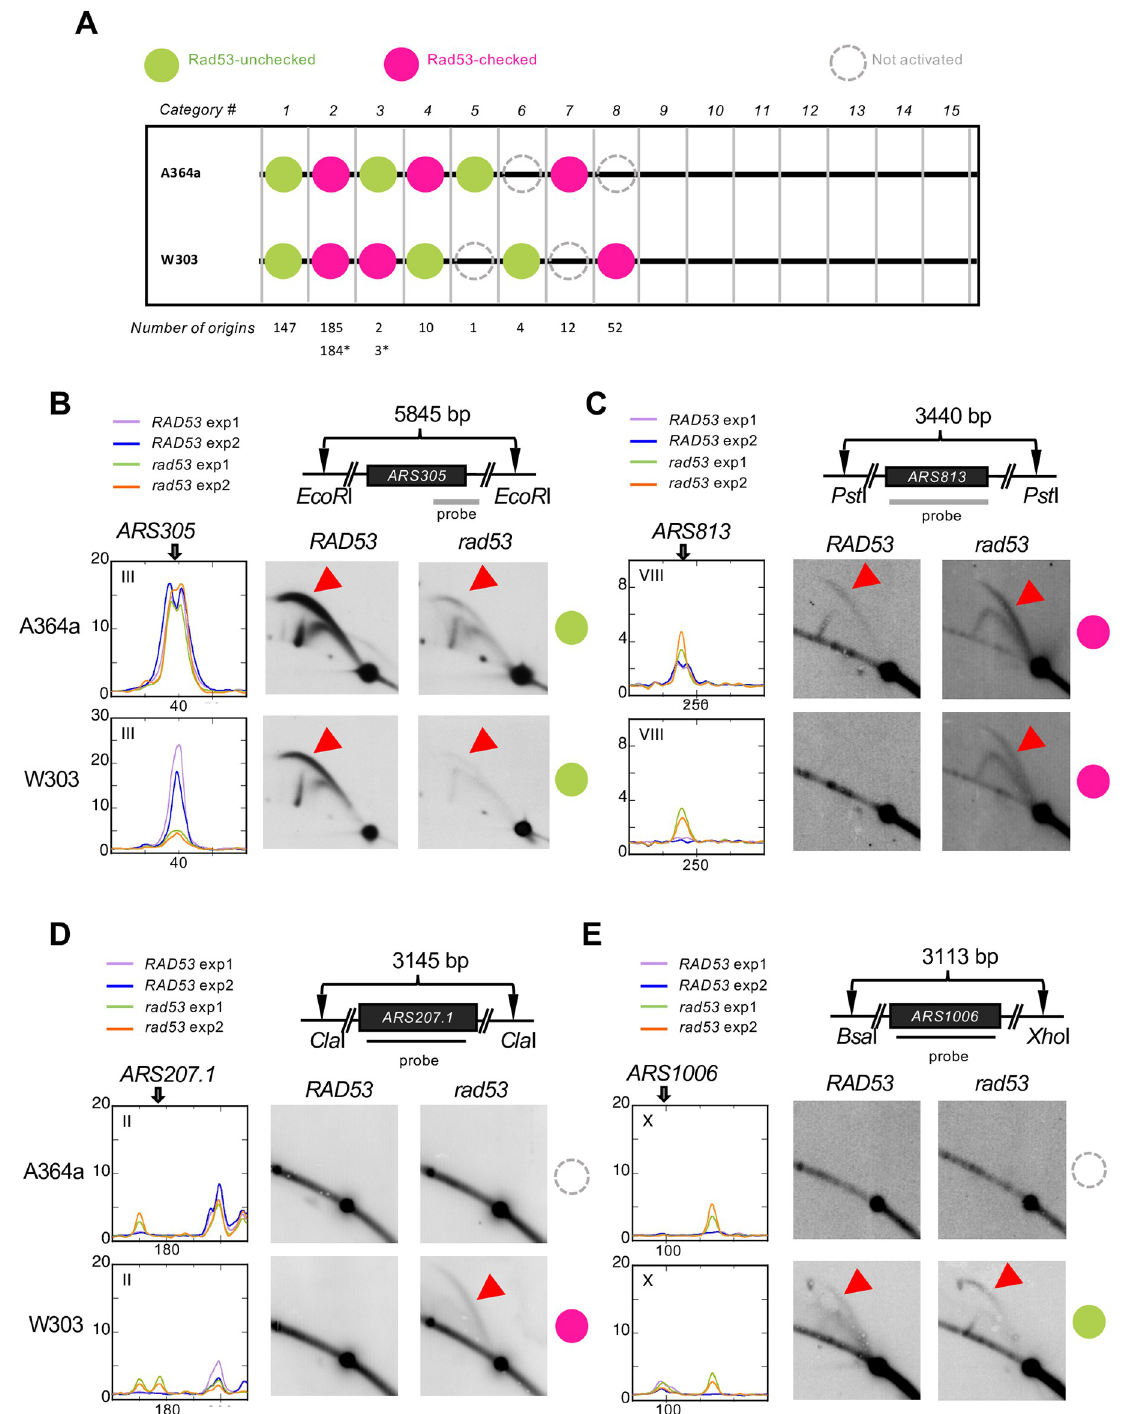
Fig 4. Validation of Rad53-checked/unchecked origin firing status using 2-D agarose gel electrophoresis. ( A ) Comparison of origin usage in the two strains leads to further classification of active origins into 15 categories. The number of origins in each category is listed below the diagram. The numbers with asterisks are the adjusted number after manual inspection. See text for detail. ( B-E ) DNA fragments containing select origins for analysis ( ARS305 , ARS1006 , ARS207 . 1 , and ARS813 ) were produced by restriction digestion with the indicated restriction enzymes. DNA probes are shown as black bars. Origin position is as indicated on the ssDNA profiles from two biological replicate experiments. “Bubble arcs” indicative of origin activation are indicated as red arrowheads. The origin classes were indicated using the key described in ( A